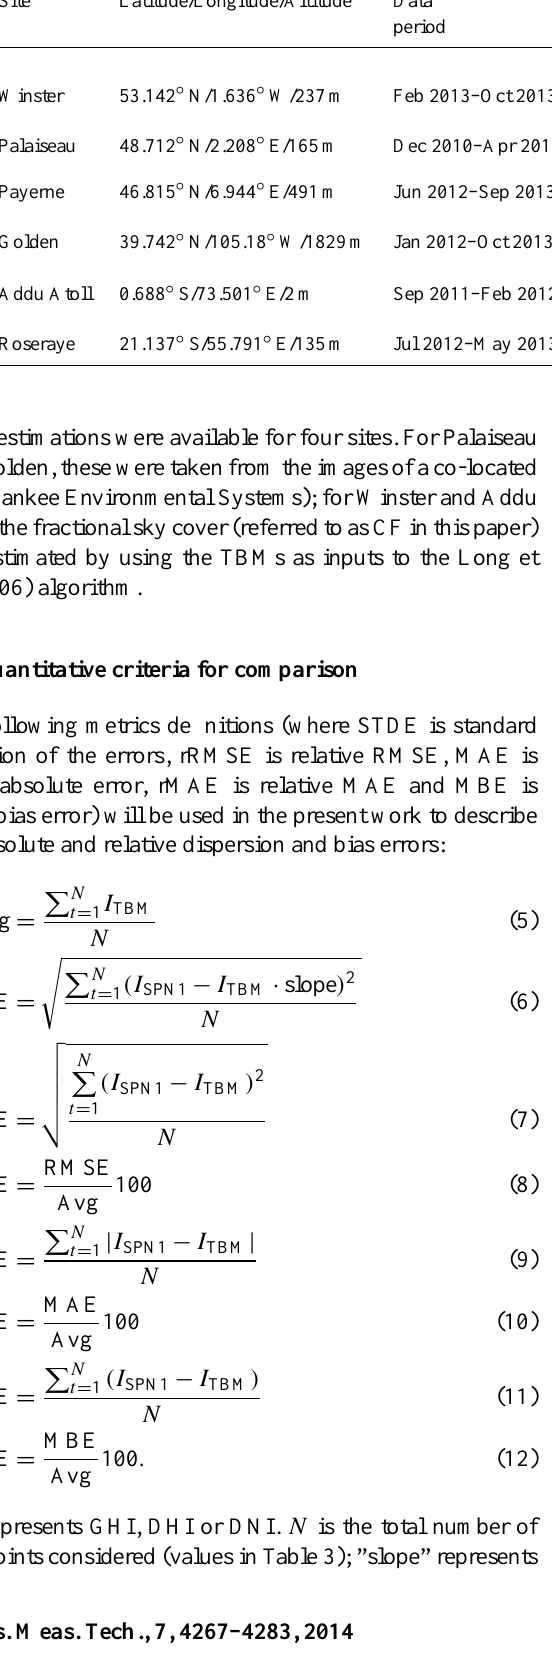
Table!2:!Sites,!data!periods!and!instrumental!information! 720! Site!